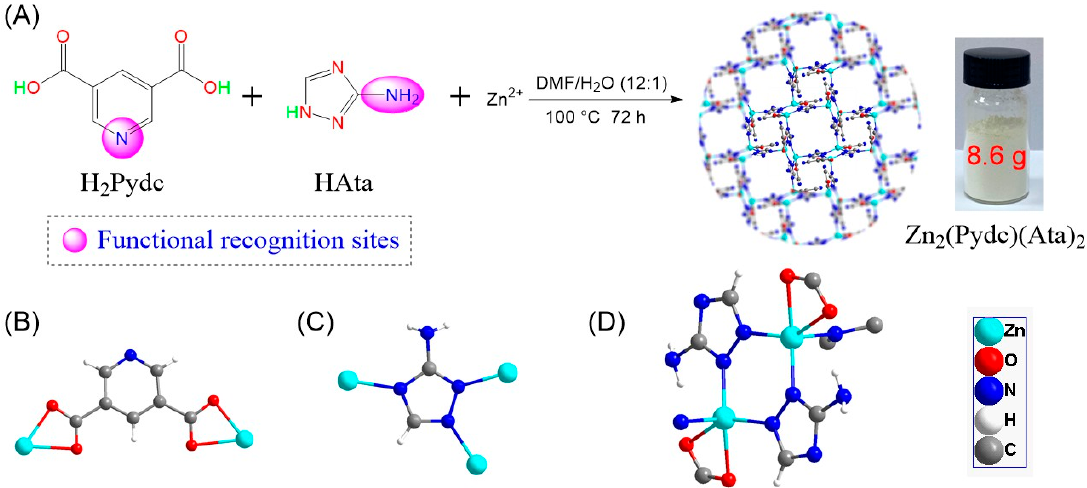
Figure 1. ( A ) Structure of 1 showing the 1D channel with two different dimensions. ( B , C ) Connolly isosurface mapping on 1.